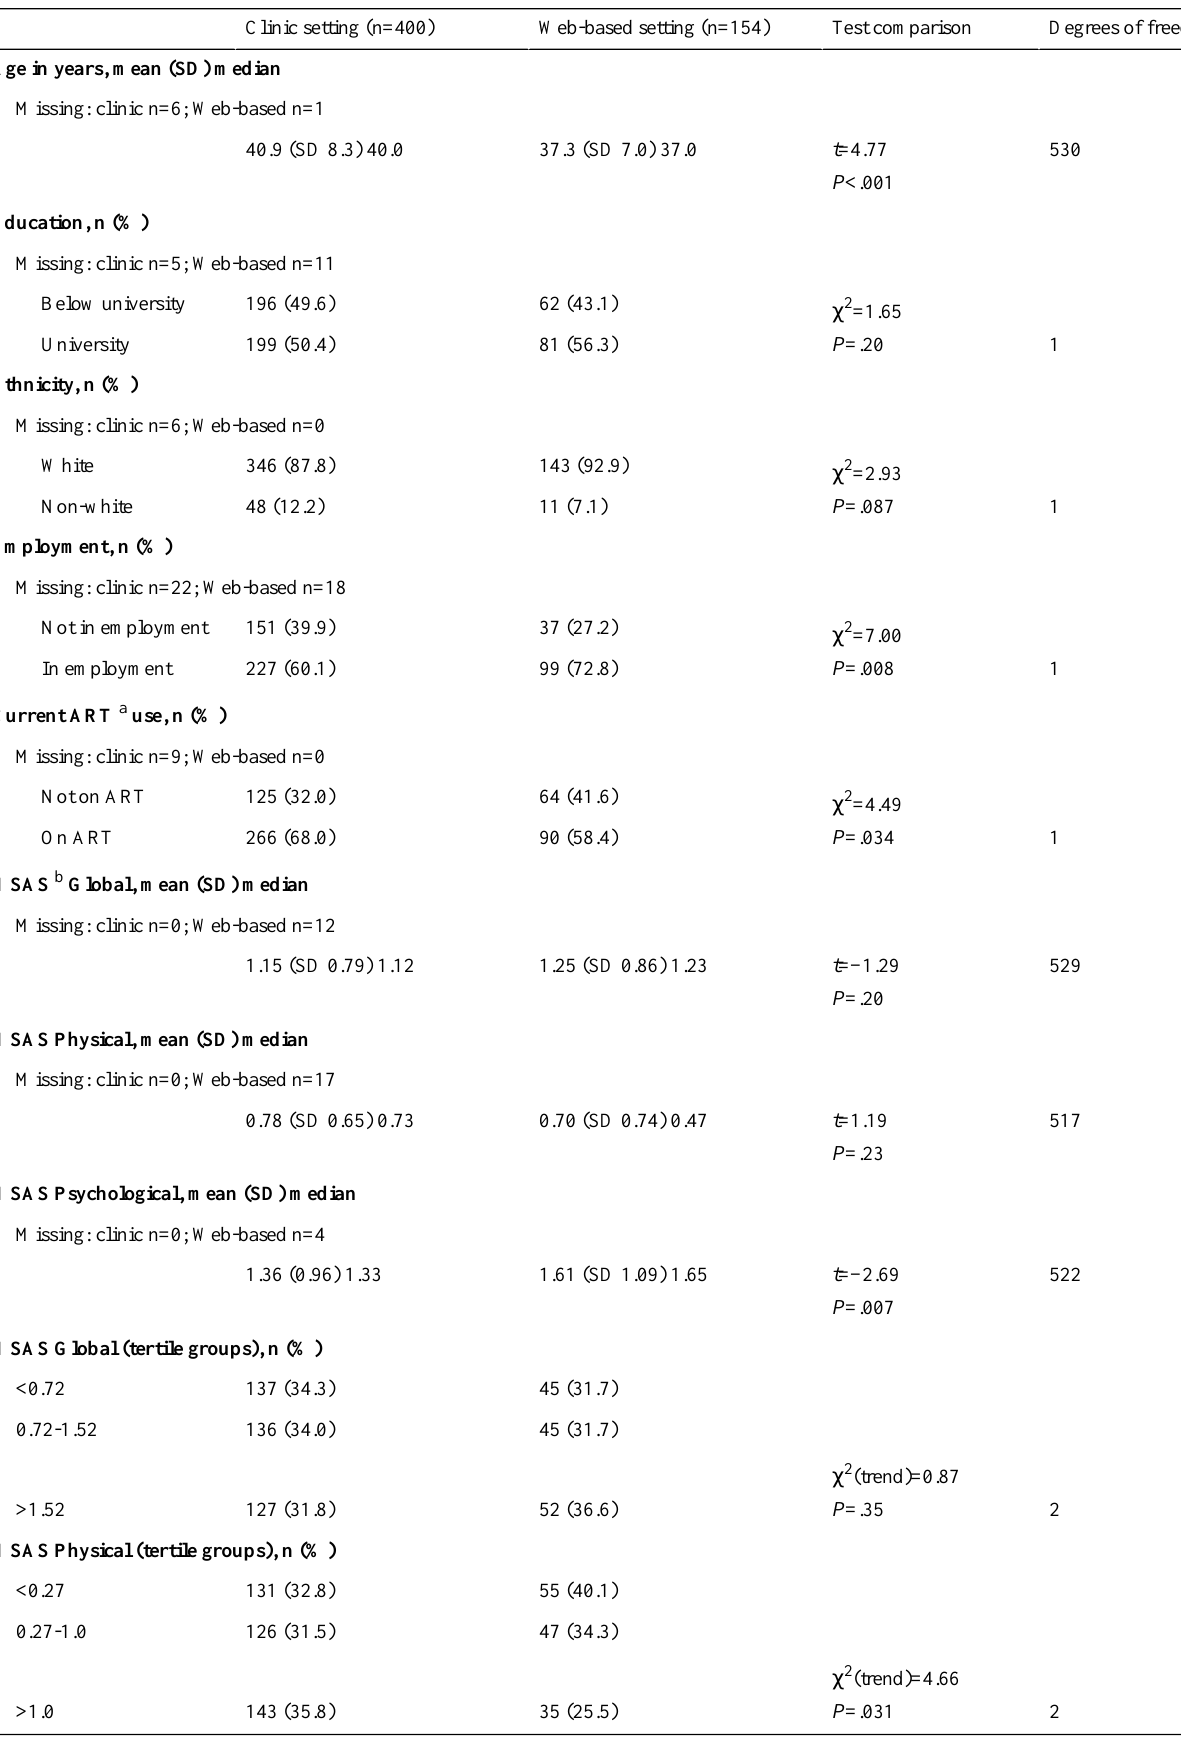
Table 1. Univariate comparison of the clinic versus Web-based samples.